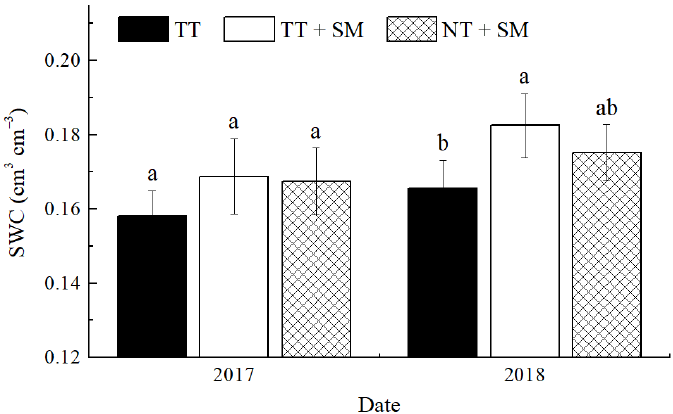
Figure 4. Mean volumetric soil water content (SWC) in the top 30 cm profile at the end of each fallow period, for the TT, TT + SM, and NT + SM treatments. TT: traditional tillage for maize cultivation without straw return after maize harvest; TT + SM: traditional tillage with 100% straw mulching after harvest; NT + SM: no-till cultivation combined with 100% straw mulching. Means in the same year followed by a different letter are significantly different ( p = 0.05).